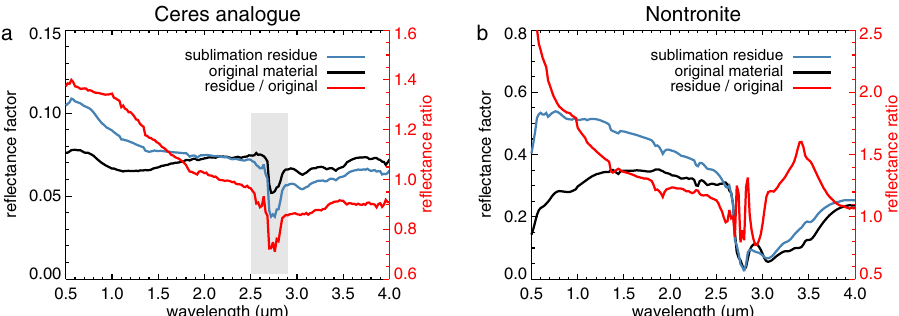
Fig. 7 Spectral changes induced by the sublimation process at the standard geometry. a Ceres analogue sample. The re fl ectance of the sublimation residue features absorption bands associated with water vapour, which affects the band depth in the range indicated by the grey box. b Pure nontronite sample (Supplementary Note 1). The ratio spectra are characterized by negative spectral slopes up to about 2.5 μ m, meaning that the sublimation residues are bluer than the